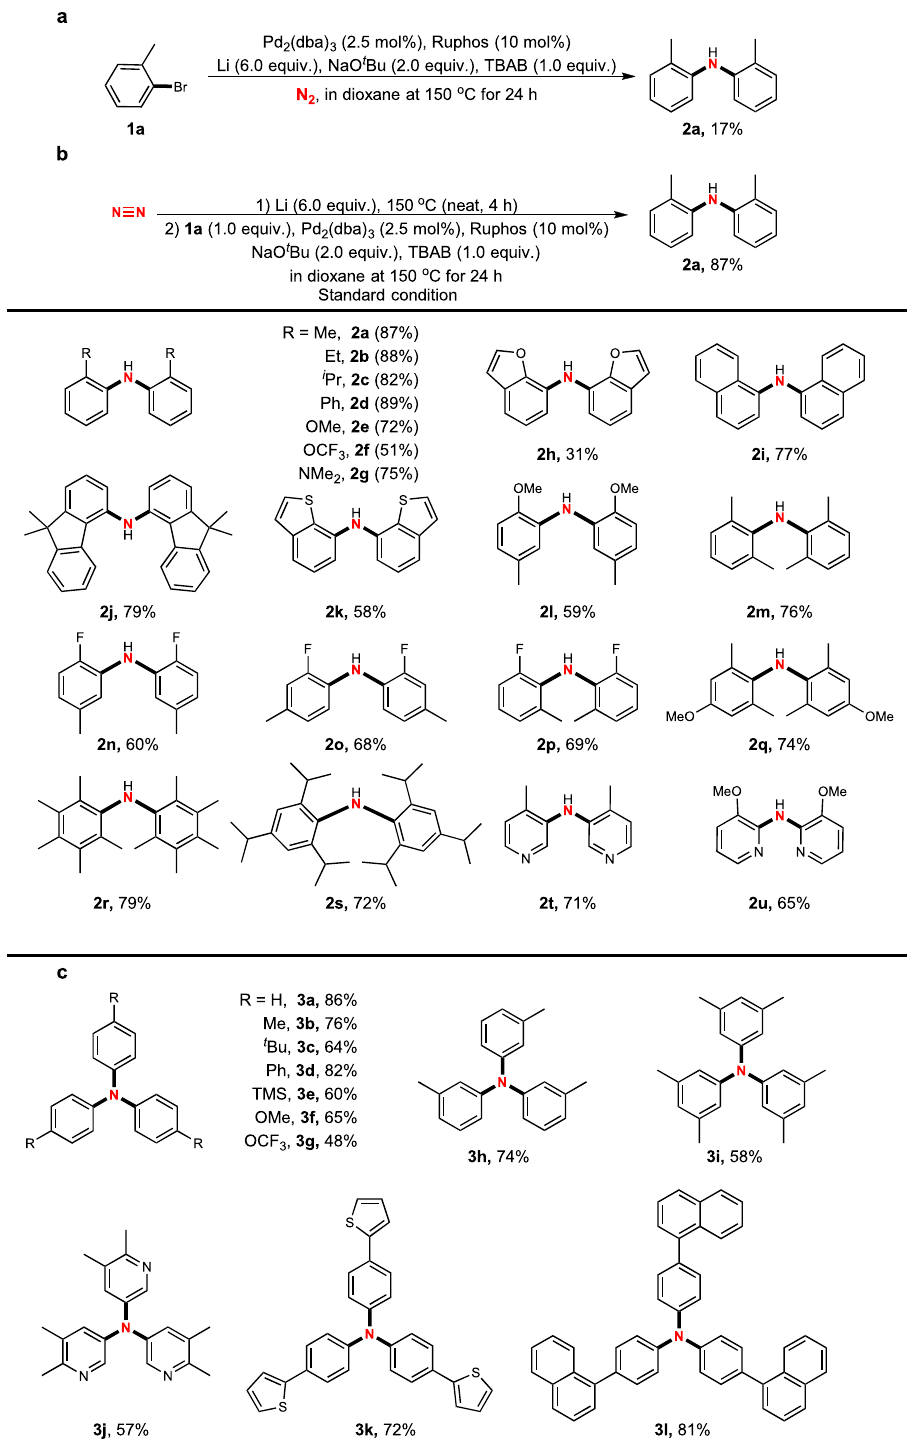
Fig. 2 Direct nitrogenation using dinitrogen (N 2 ) to synthesize bi/triarylamines. a Catalytic C – N formation using dinitrogen (N 2 ) to synthesize bi( o -tolyl) amine. b One-pot/two-step nitrogenation for the synthesis of diarylamines directly from ortho-substituted aryl bromides using dinitrogen (N 2 ). c